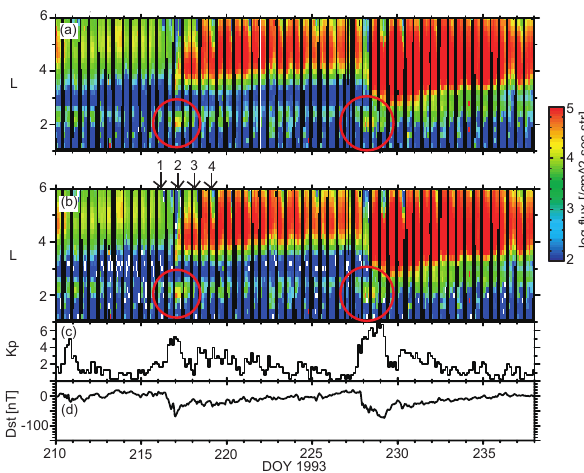
Fig. 1. L-t diagram for a 300-keV electron flux derived from the 90 ◦ sensor (a) , and after subtraction of the count rates of the 0 ◦ sensor from that of the 90 ◦ sensor (b) . (c) The K p index. (d) The D st